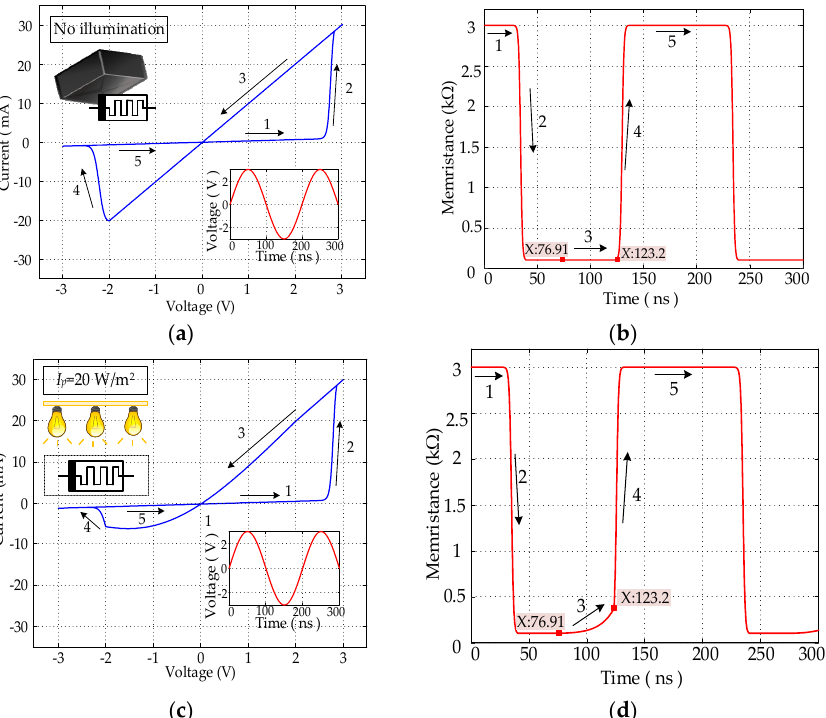
Figure 3. Simulation results under sine-wave voltage showing ( a , b ) I − V and M − t curves without illumination; and ( c , d ) I − V and M − t curves at optical radiation intensity of 20 W/m 2 .